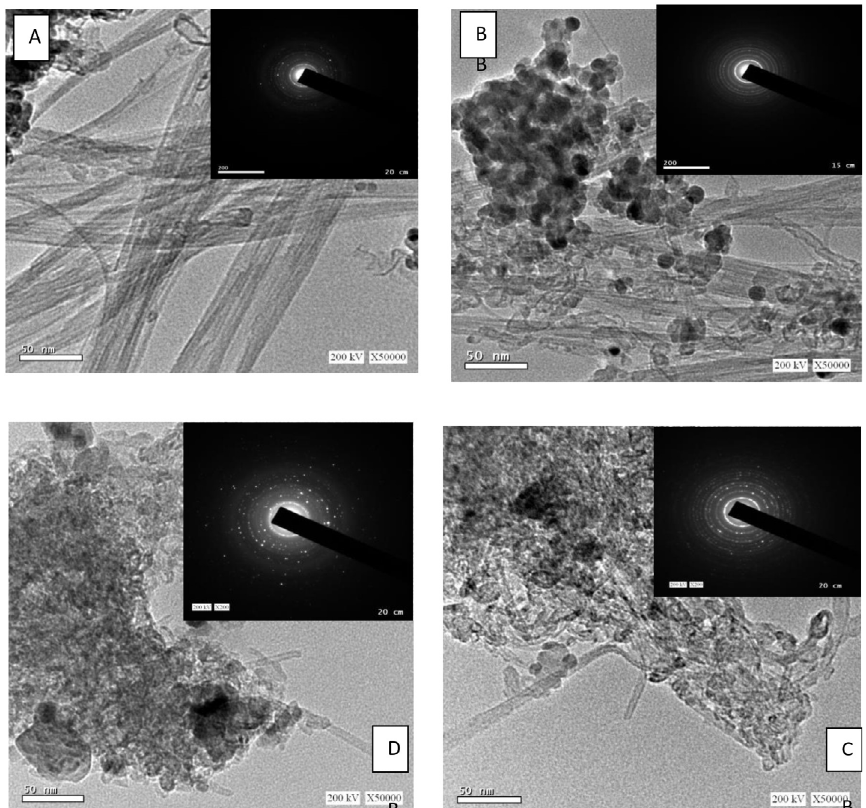
-SWCNT (C) TevAg -SWCNT and (D) TevAg 2 6